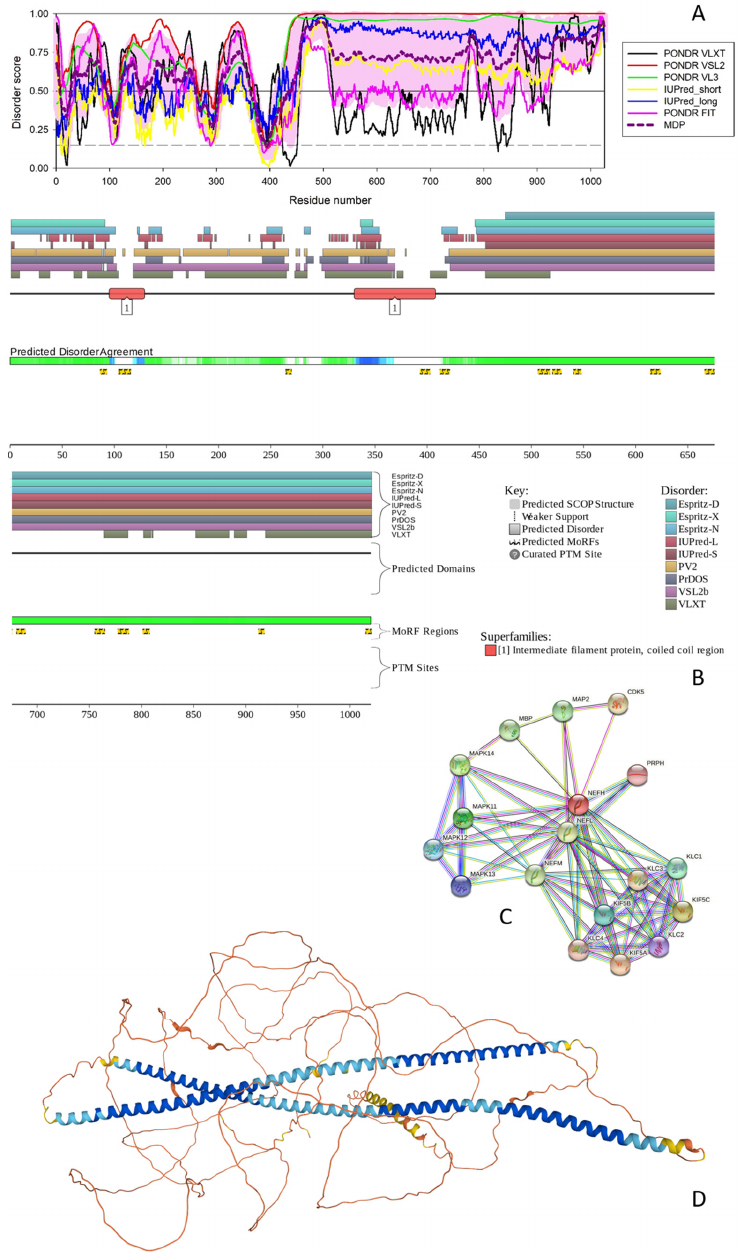
Figure 1. Functional disorder analysis of human NFH (UniProt IDs: P12036). ( A ) Per-residue disor ‐ der profile generated by RIDAO. Solid and dashed horizontal lines at disorder scores 0.5 and 0.15